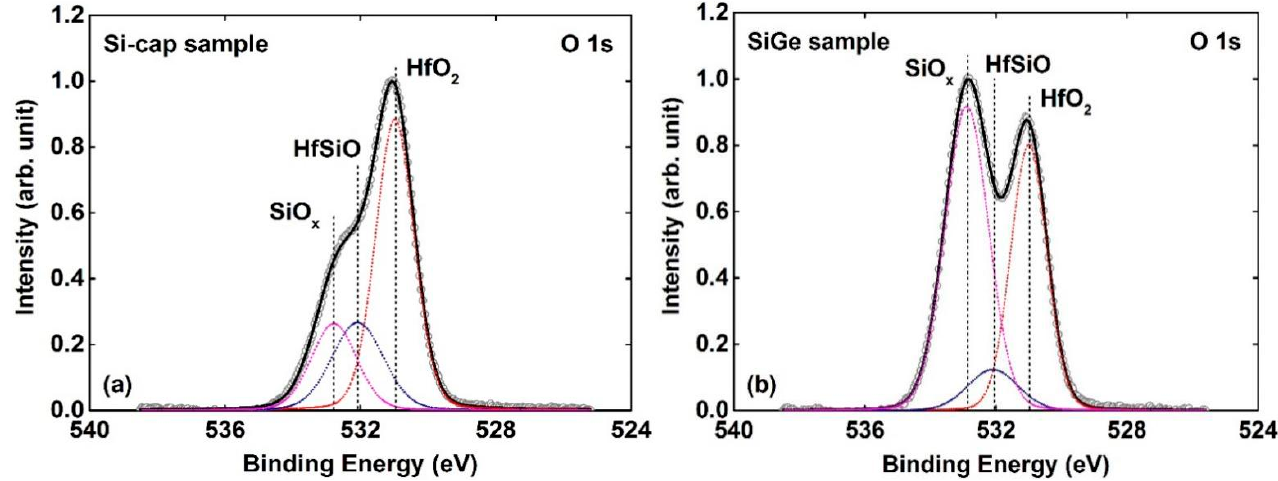
Figure 8. The fitted O 1s core ‐ level spectra of ( a ) Si ‐ cap sample ( b ) SiGe sample. The red, blue, and magenta dot lines denote the O1s photoelectron from HfO 2 , HfSiO, and SiO x , respectively.